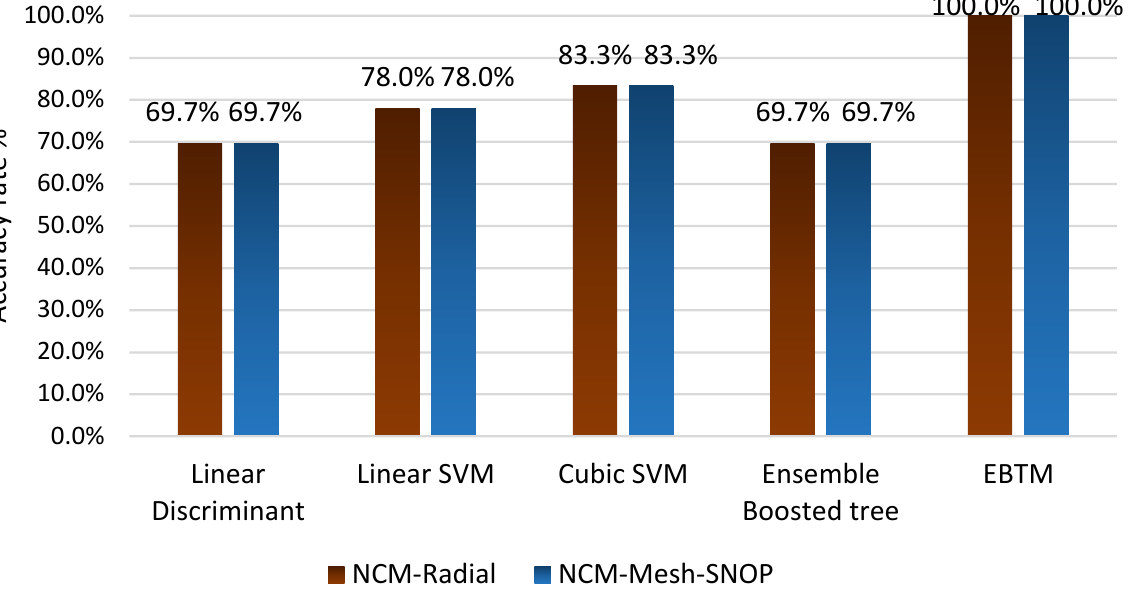
Figure 6. Comparative evaluation of the performance of five MLTs used in this research under radial and mesh-SNOP throughout NCM-DN. Table 3. Accuracies acquired by several MLTs.